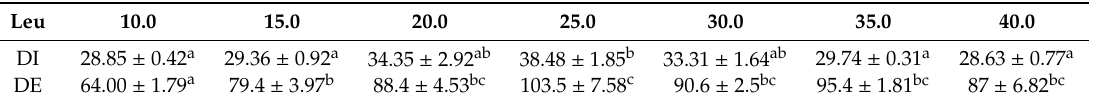
Values are means ± SEM (n = 3, 18 fi sh per treatment). Mean values with different superscripts in the same row are significantly di ff erent ( P < 0.05).